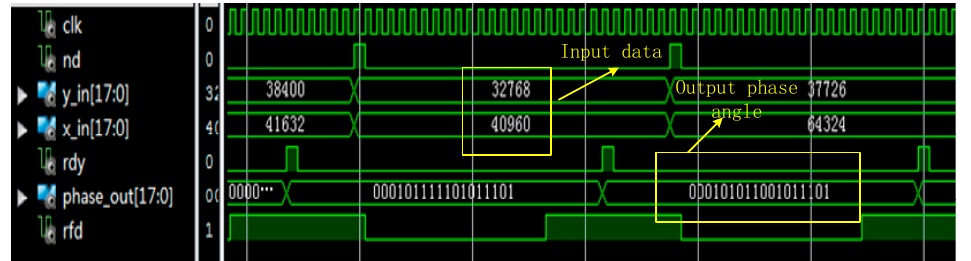
Figure 24. Simulation waveform of the phase measurement module.